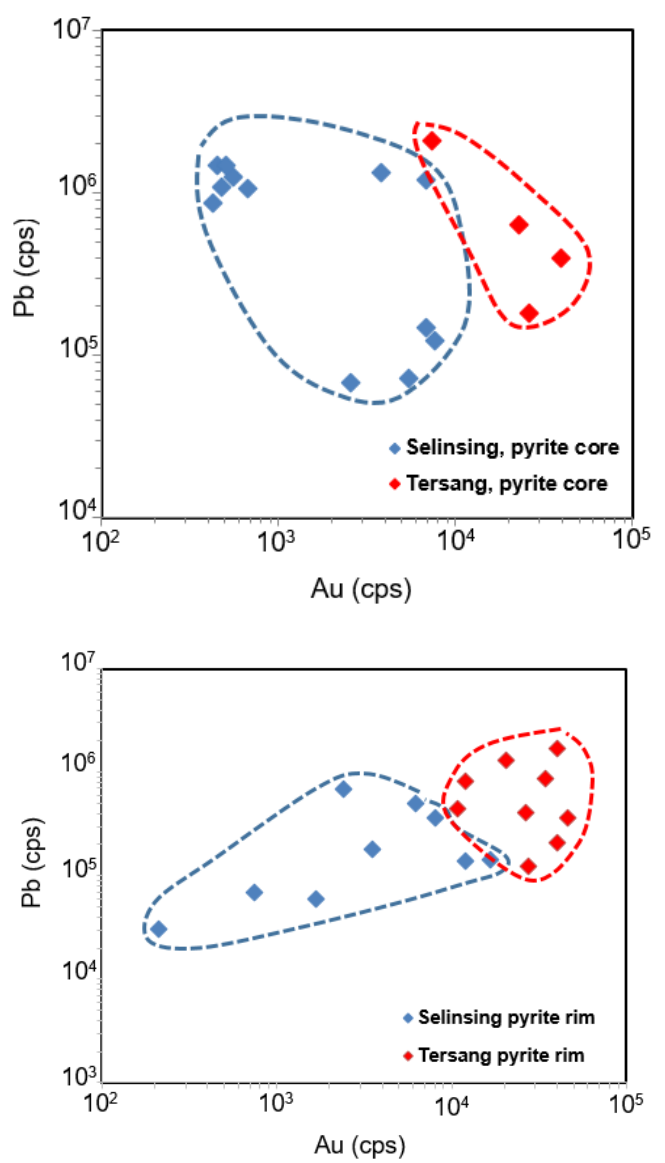
Figure 15. Plot of Pb 208 versus Au content in count per second in pyrite from the Tersang and Selinsing gold deposits, Malaysia. Selinsing gold deposits,